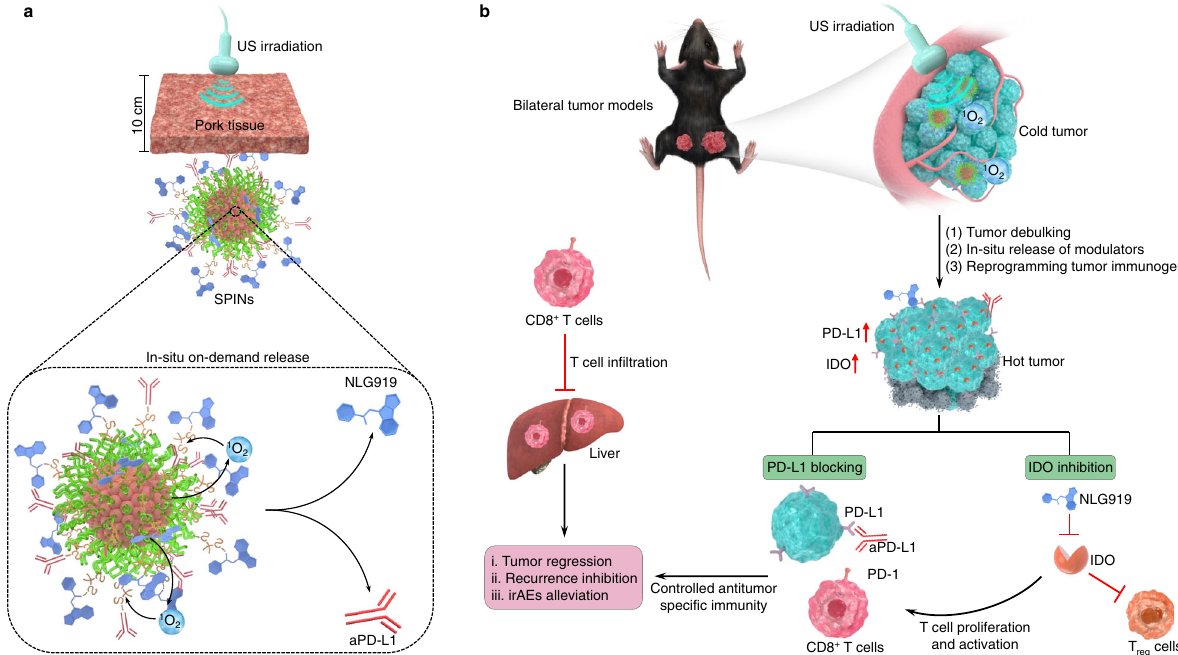
Fig. 1 Design and mechanism of SPINs for deep-tissue activatable sono-immunotherapy. a Schematic illustration of US-triggered deep-tissue activation of SPINs to release immunomodulators. b Schematic illustration of sonodynamic activation of SPINs to debulk tumor, enhance tumor immunogenicity, and release immunomodulators in situ as well as synergetic action of IDO inhibition and PD-L1 blocking on enhancing antitumor immunity with alleviated irAEs relative to free-drug